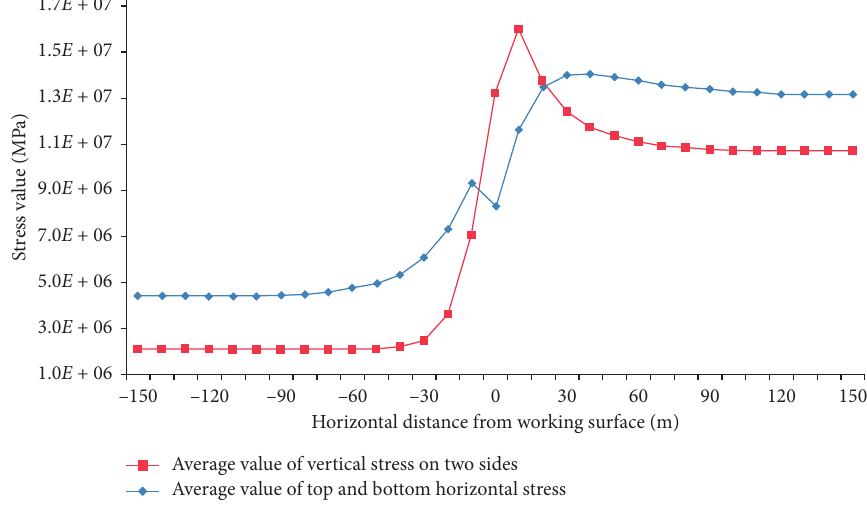
Figure 10: Circumferential stress distribution in 3 meters deep surrounding rock. Table 2: The table of support